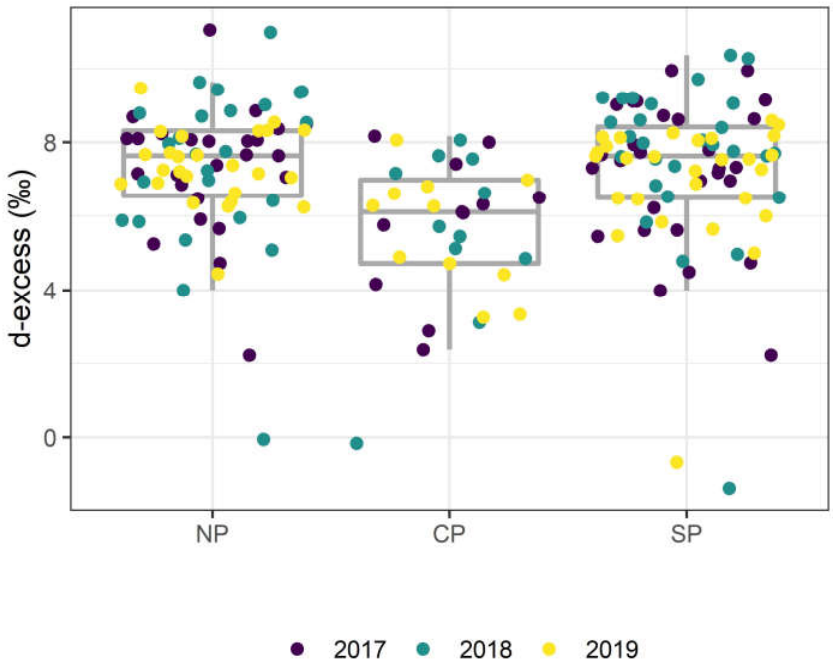
Figure 5. D-excess values over the basin parts (NP, CP, SP) and sampling years. Individual samples are shown using dots. Tukey outlier box plots show the median value (horizontal line within the box), the 1st and 3rd quartile (ends of the box), and the minimum/maximum values (whiskers).